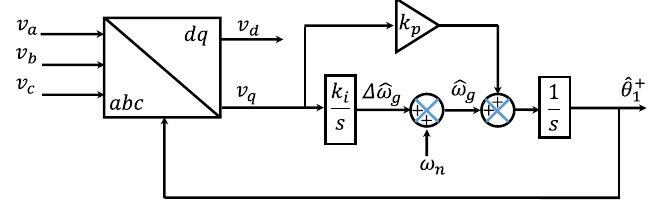
Figure 1. Conventional SRF-PLL block diagram.